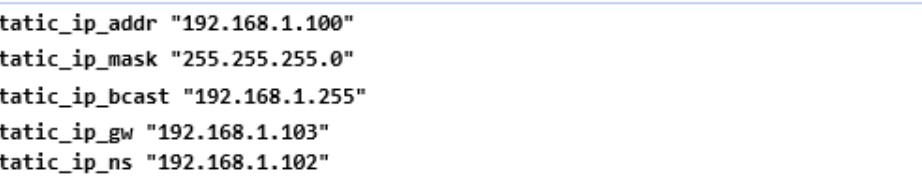
Figure 14. Command to connect to devices.